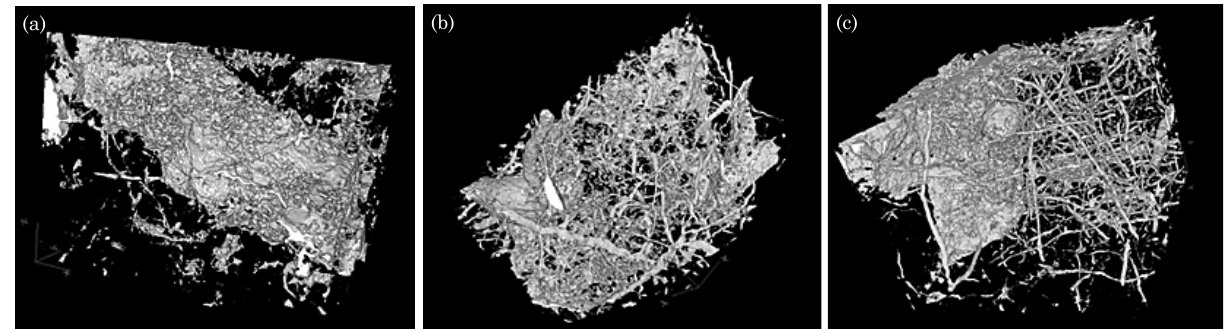
figure 7. microtomographic images of the soil macropore system (White): (a) 0-10 cm layer, (b) 10-20 cm layer, and (c) 20-30 cm layer. the image resolution obtained was 60 μm.